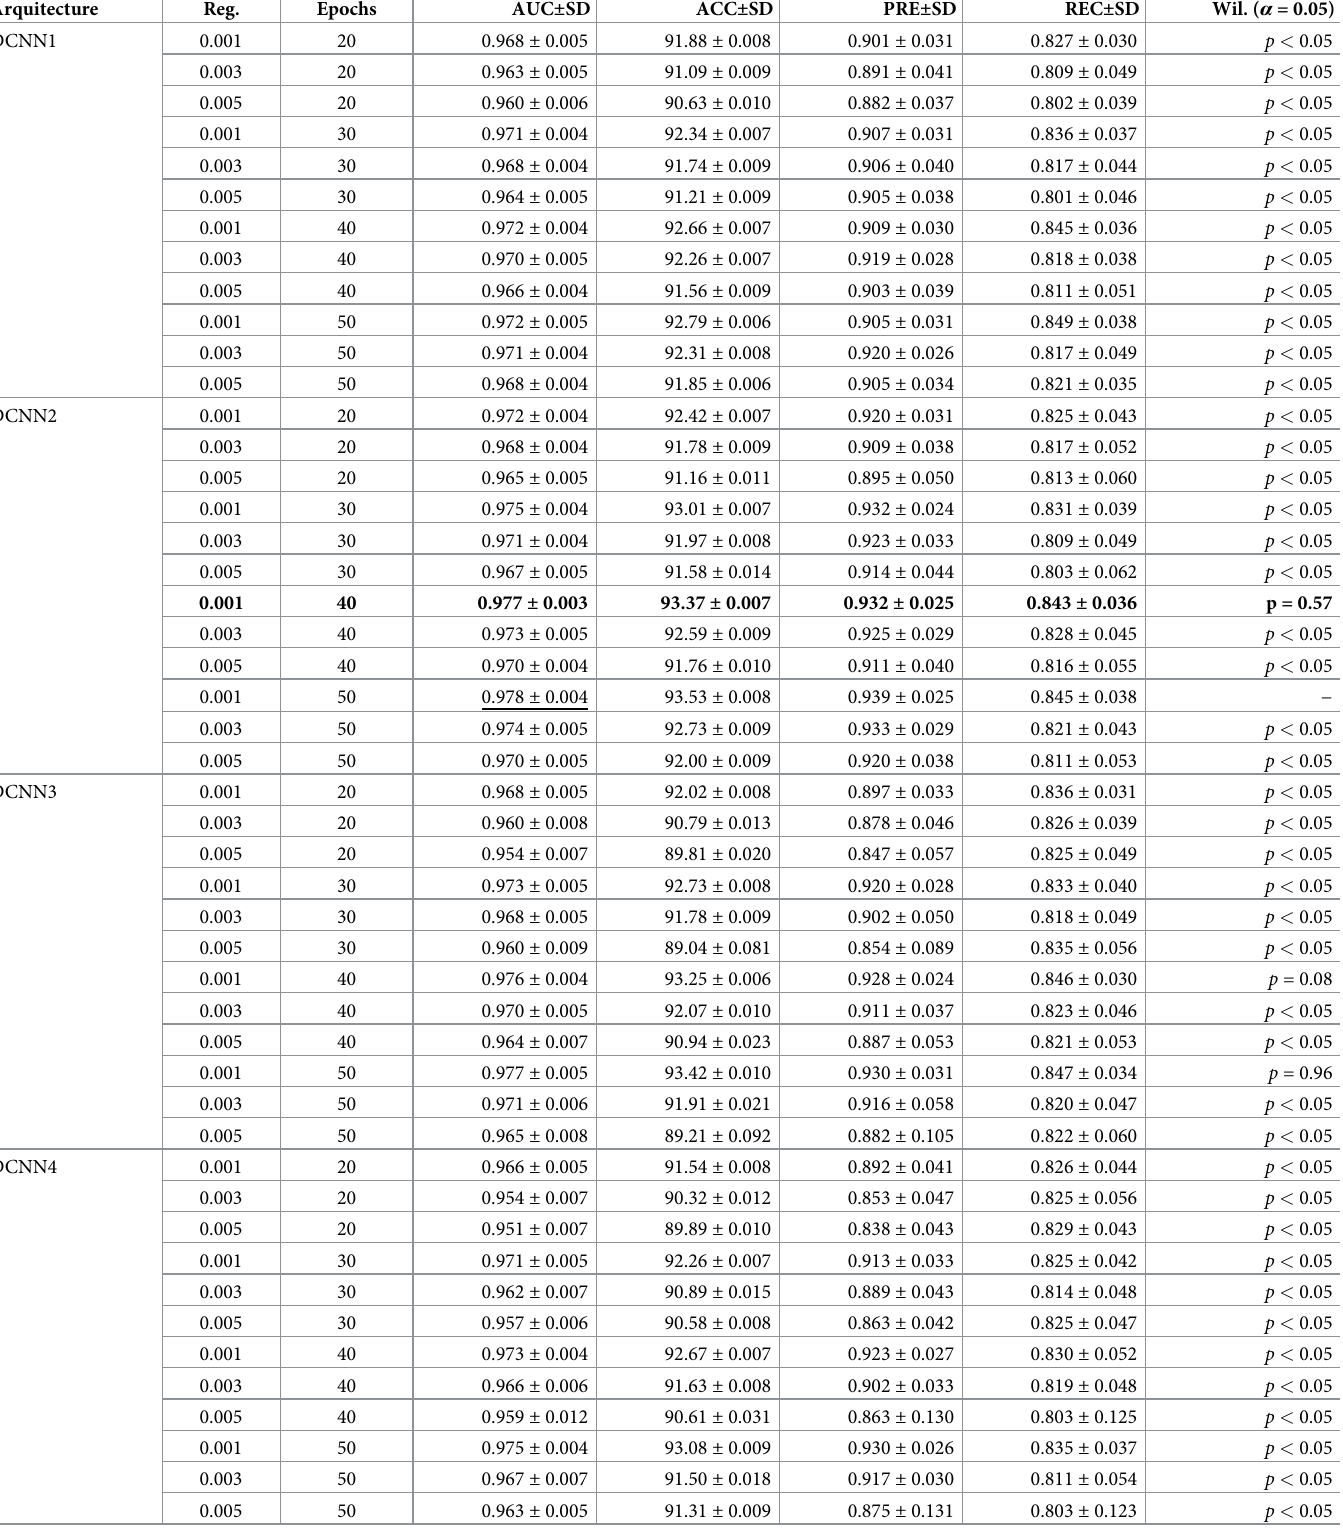
Table 2. Performance results of proposed deep CNN models.